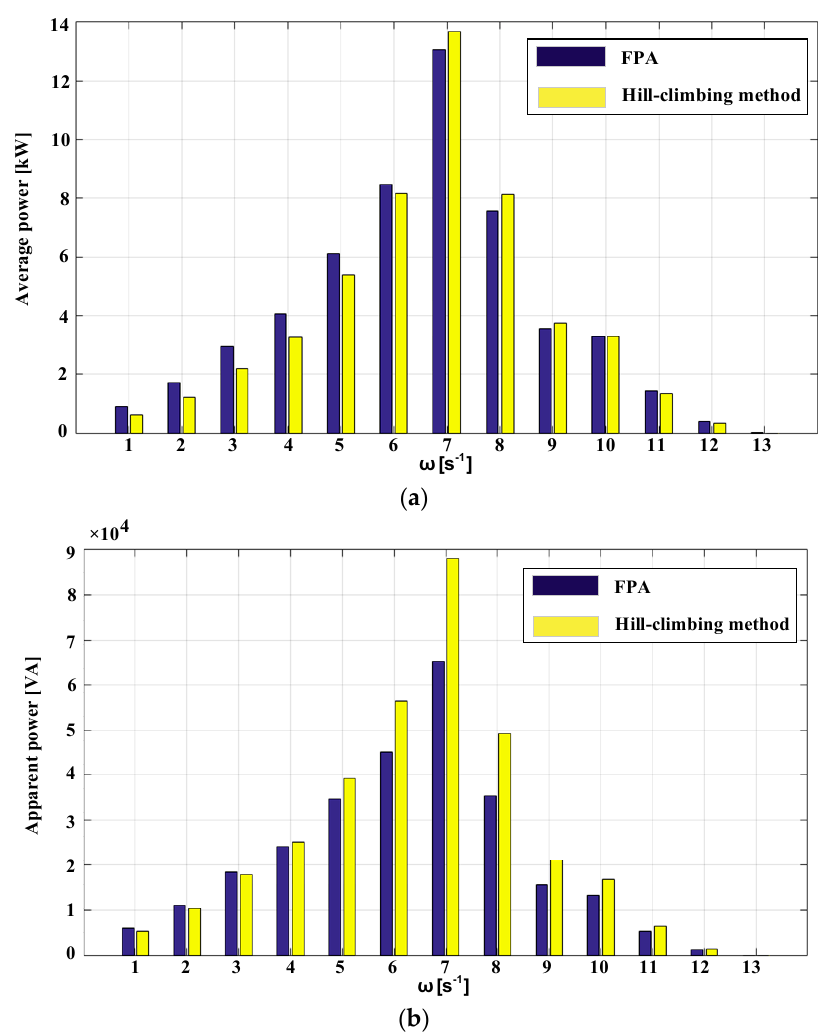
Figure 11. Simulated power spectrum of ( a ) average power, ( b ) apparent power.